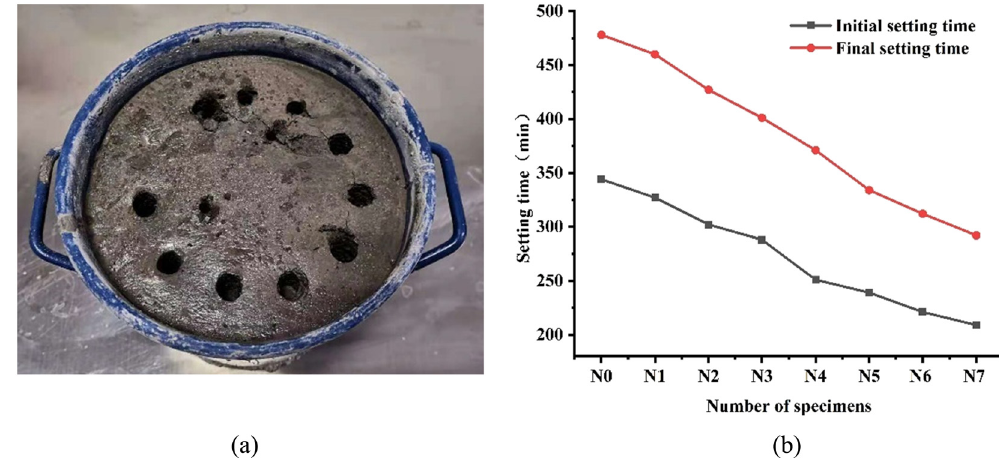
Figure 3: Setting time of concrete. ( a ) Testing of concrete setting time. ( b ) Initial and fi nal setting time of